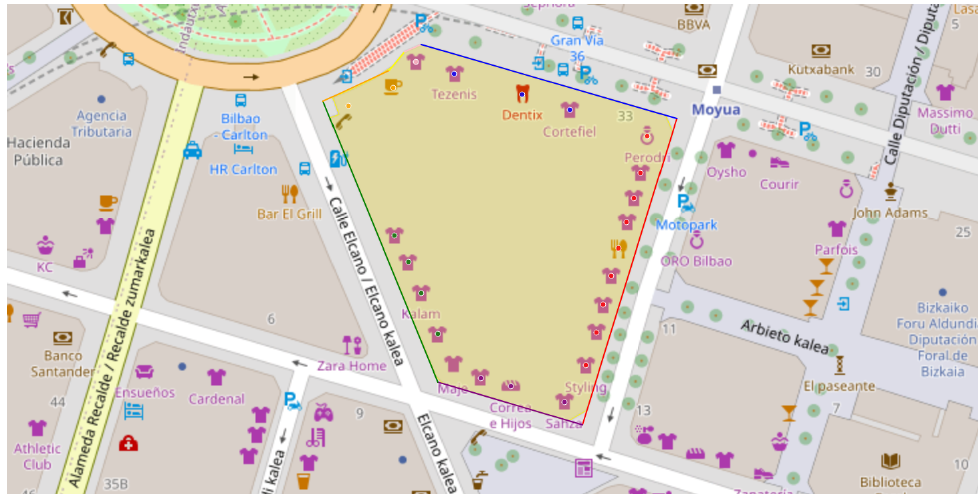
Figure 18. The neighbouring nodes per edge. Then, the two nearest neighbors per edge are selected (see Figure 19). If the analyzed store were the middle of an edge, it would have had one neighbor on both sides.